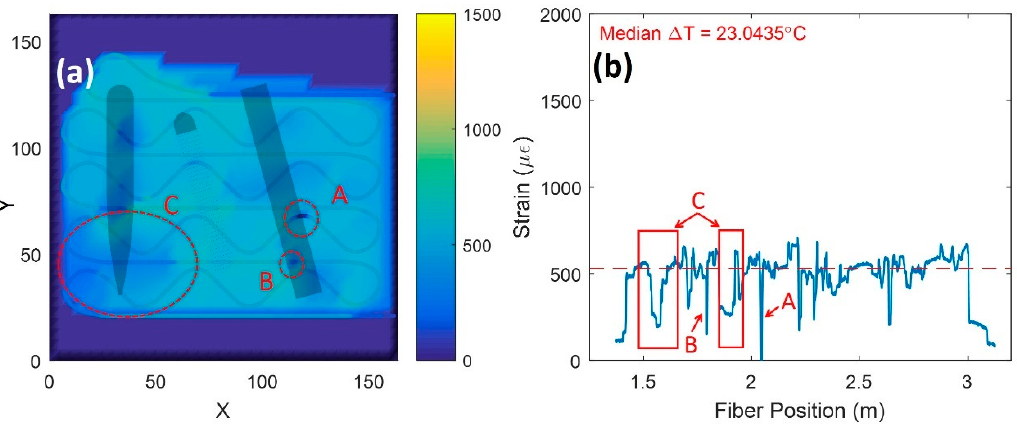
Figure 7. Spatial mapping of fiber data: ( a ) spatial map of fiber data with superimposed parts; ( b ) raw fiber data showing strain accumulation from heat generation from laser at layer 58.